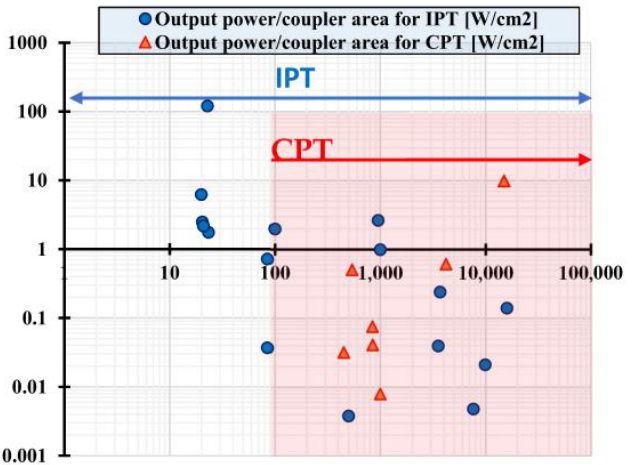
Figure 6. Graph of OUTPUT POWER/COUPLER AREA (W/cm 2 ) vs. FREQUENCY (kHz).